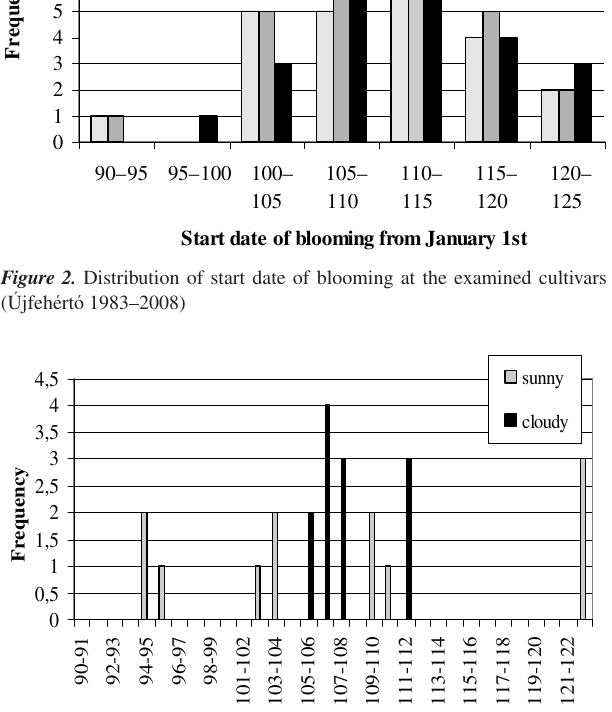
00,511,522,533,544,5